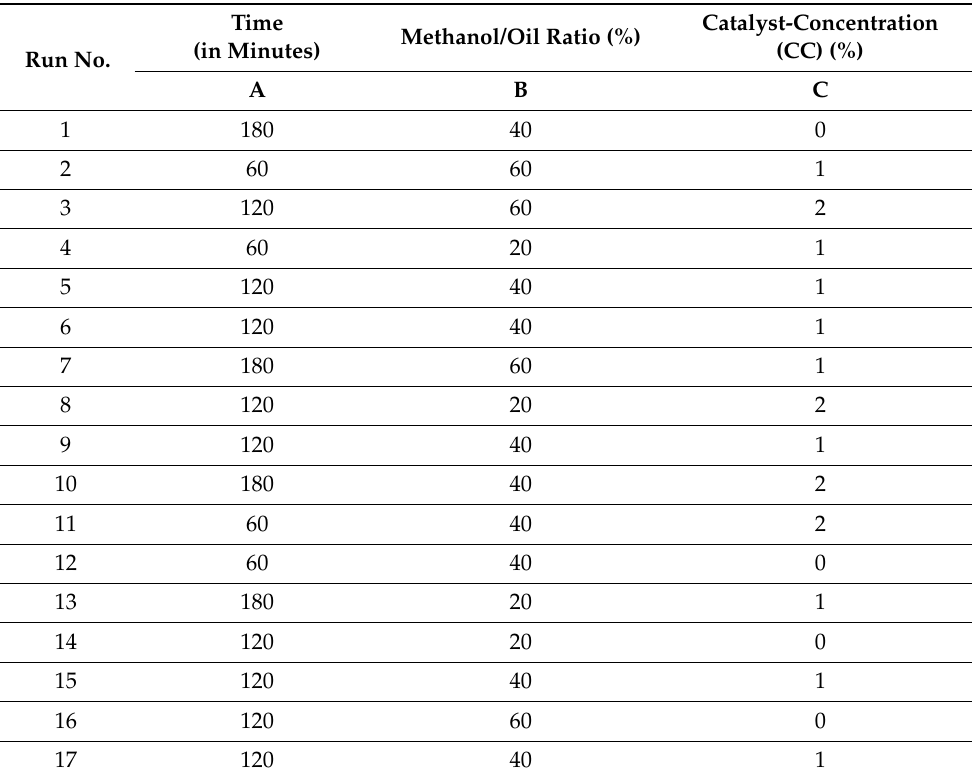
Table 3. List of trials designed with BBD.